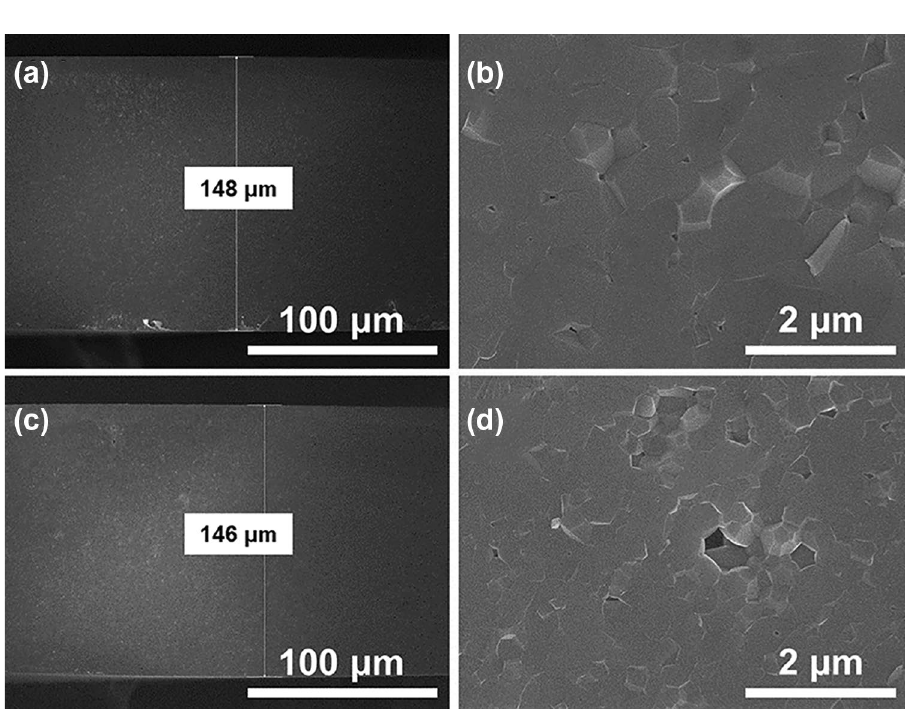
Figure 6. Cross-sectional SEM images of a CP fabricated under different pressure conditions. ( a , b ) zero MPa, ( c , d ) 50